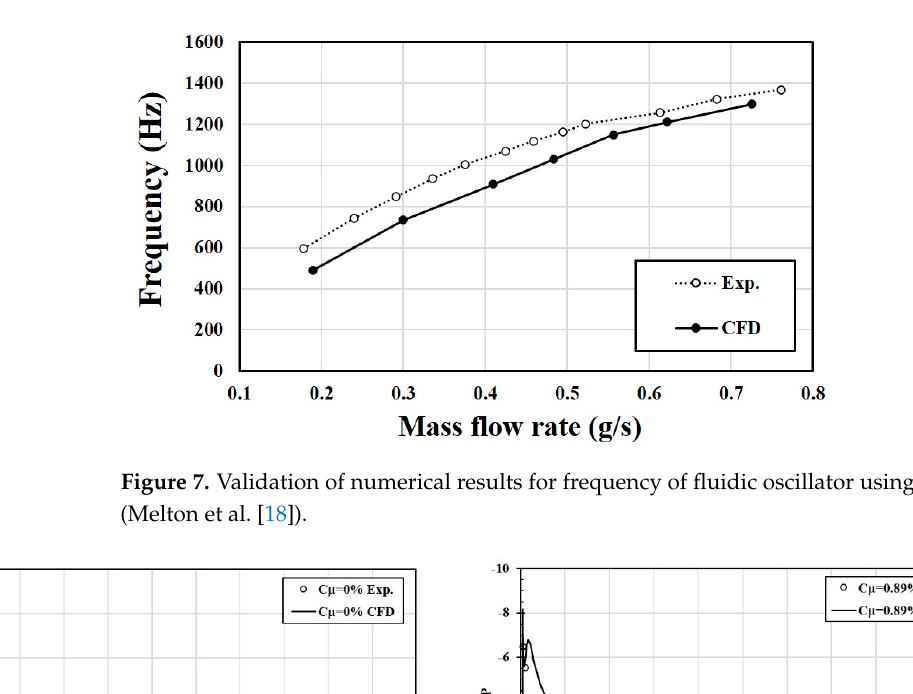
Figure 7. Validation of numerical results for frequency of fluidic oscillator using experimental data (Melton et al. [18]).